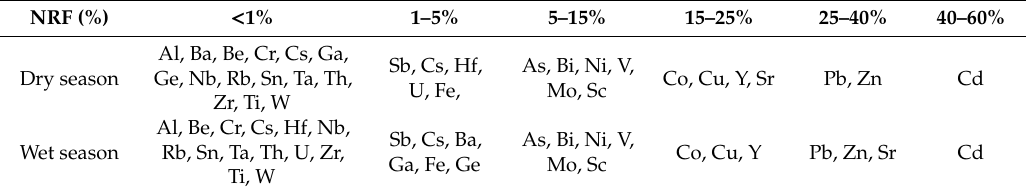
Figure 10. Distributions (percentage on a logarithmic scale) of non-residual (labile) and residual fractions for one TE of anthropogenic origin, Cd ( left ) and one TE of natural origin, Zr ( right ) in the di ff erent sediments of the Lom é lagoon (S4 to S12) for the dry (DS) and the wet (WS) seasons. Table5. DistributionoftheNRFpercentagesforthedi ff erentTEmeasuredintheLom é